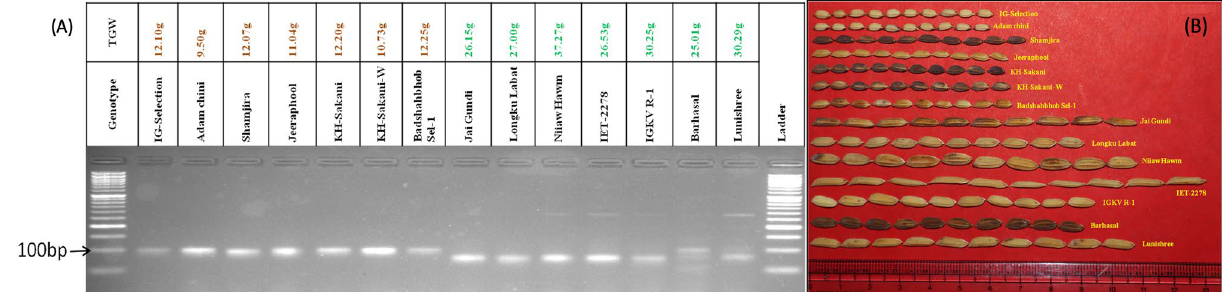
Figure 7. ( A ) Validation of marker RM7197, peak marker of MQTL3.1 on set of seven low grain weight and seven high grain weight genotypes. The allele with 100 bp linked to low grain weight and 85 bp allele linked to high grain weight. ( B ) Representation of grain size and shape of genotypes used for validation of identified MQTL.